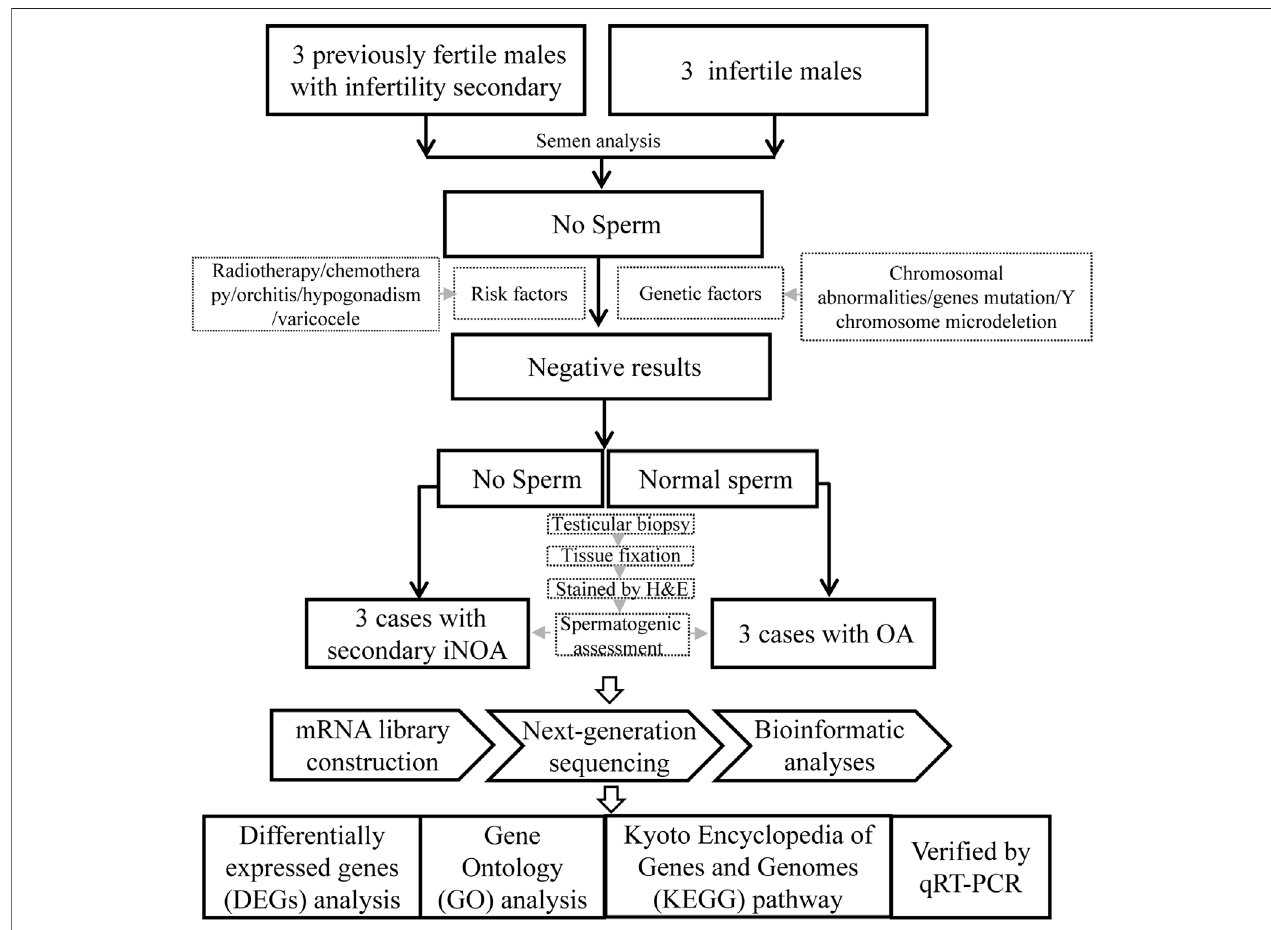
FIGURE 1 | The fl owchart of the experimental